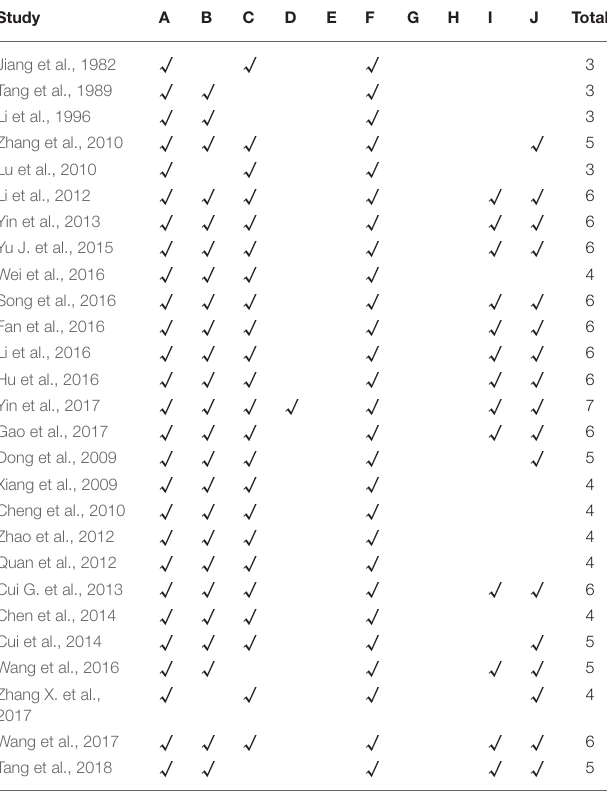
TABLE 5 | Risk of bias of the included in vitro